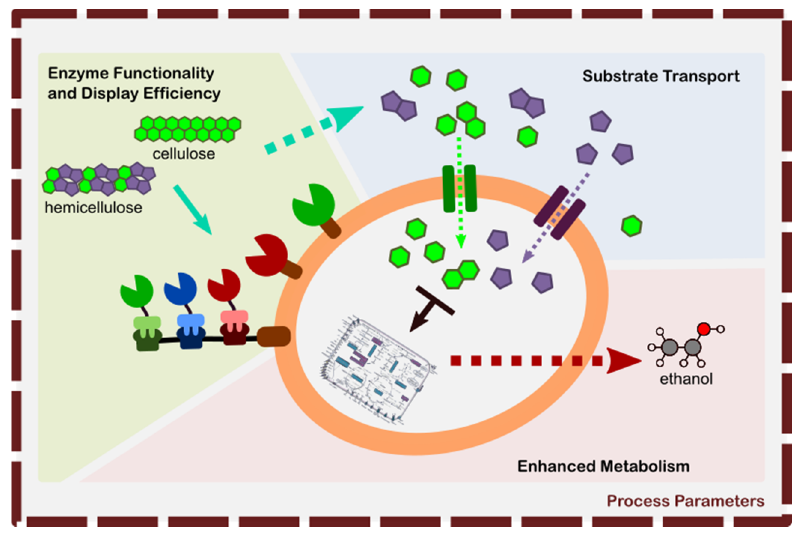
Figure 10. Schematic illustration for the different avenues of improvement for yeast surface display in bioethanol fermentation from lignocellulosic biomass.